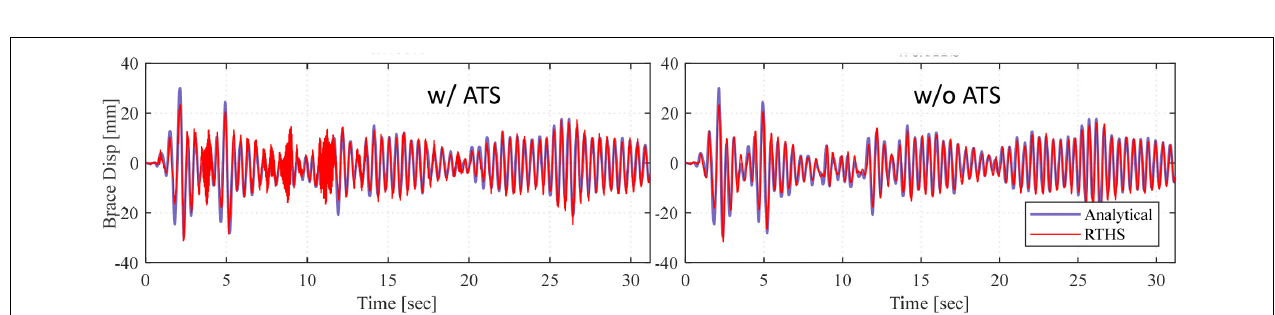
FIGURE 23 | RTHS response comparison with analytical solution for Model 1 (S L = 15) with and without using ATS when the last row of the force input was selected to be updated.